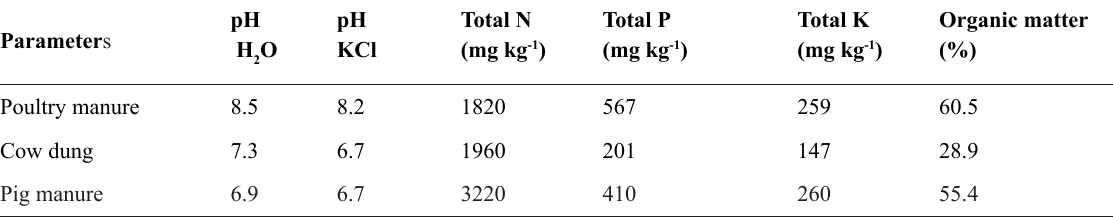
Table 1 Initial chemical properties of the animal manures used for the study Parameter s Poultry